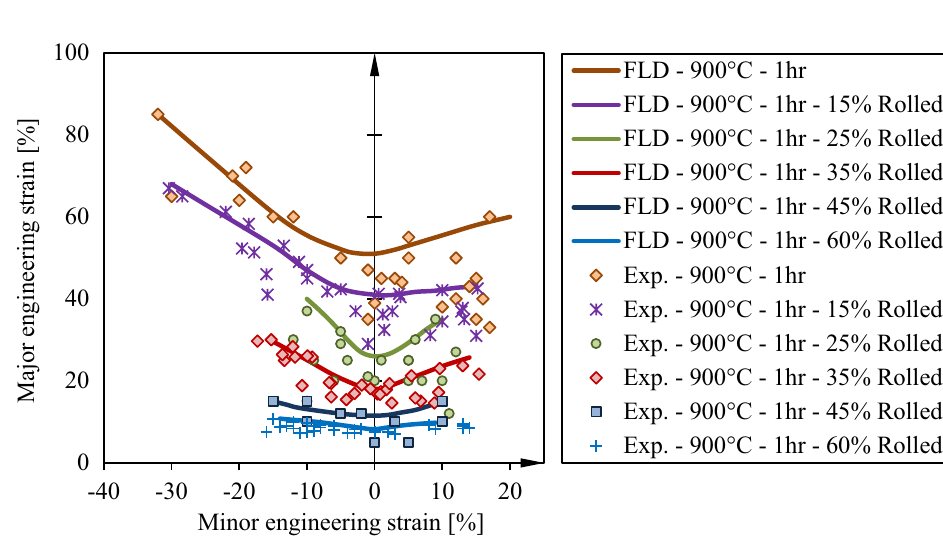
Figure 7. Foming limit curves of St14 steel sheets before and after cold